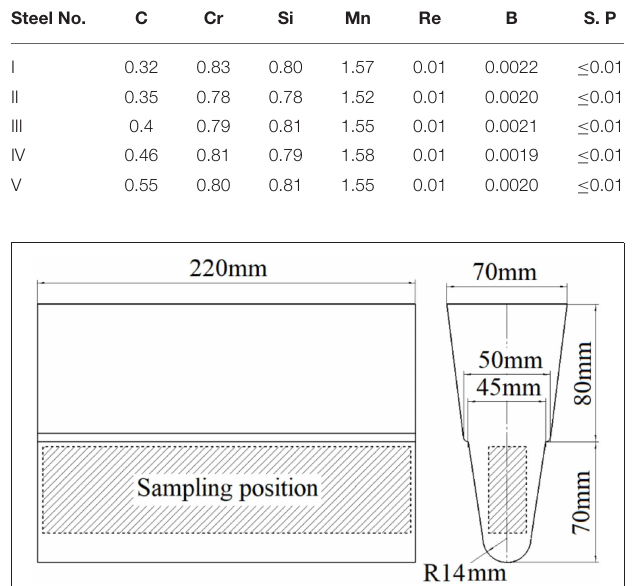
FIGURE 2 | Schematic illustration of the MDL-10 impact wear tester. 1-hammer, 2-clamping chuck, 3-test specimen, 4-down specimen,